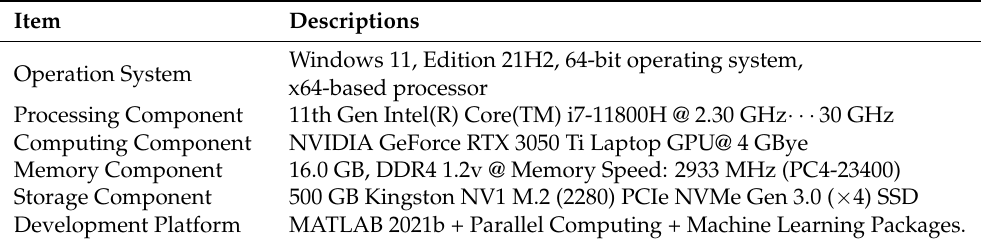
Table 3. Simulation Environment Specifications (Hardware and Software).